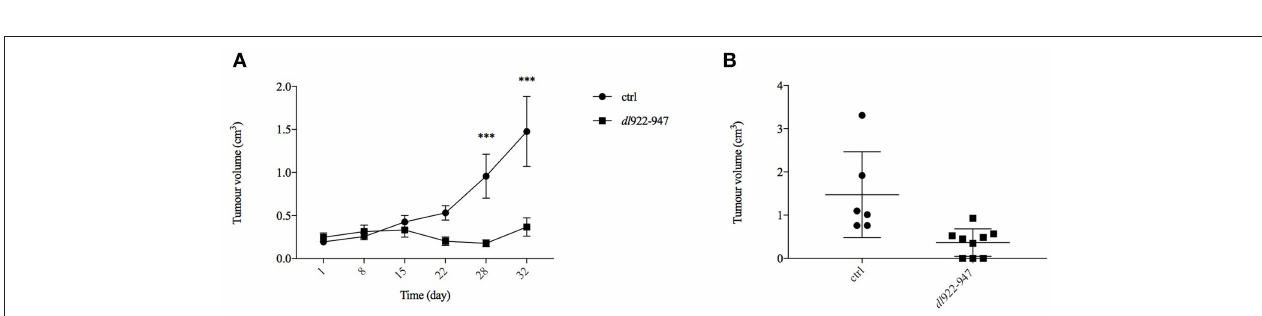
FIGURE 5 | Effect of dl 922-947 on VEGF-A and IL-8 production by MPM cells. MSTO-211H and NCI-H28 cells were infected with dl 922-947 at the IC50. VEGF-A and IL-8 secretion was assessed by ELISA 48 hpi. The histograms represent the mean of six independent experiments ± s.d. The statistical analysis was performed by Mann-Whitney test (* p < 0.05).